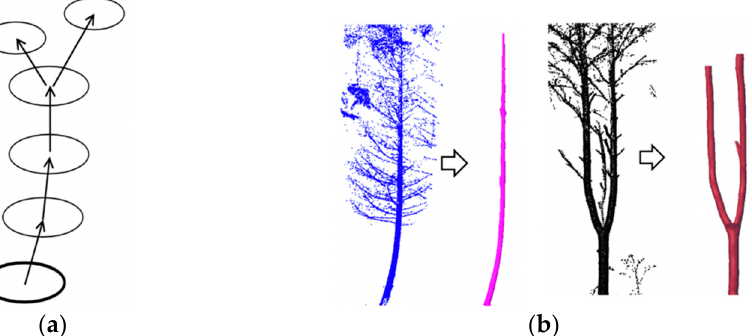
Figure 14. Extraction of each stem from stem sections. ( a ) Overlapping closed curves; ( b ) reconstruc- tion of stem shapes.